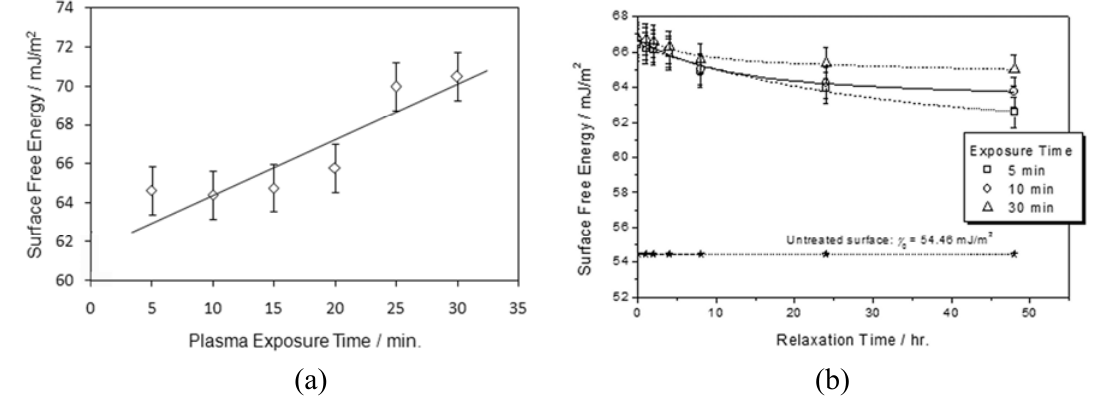
Figure 5. Surface free energy of the substrate versus the exposure period of the substrate to